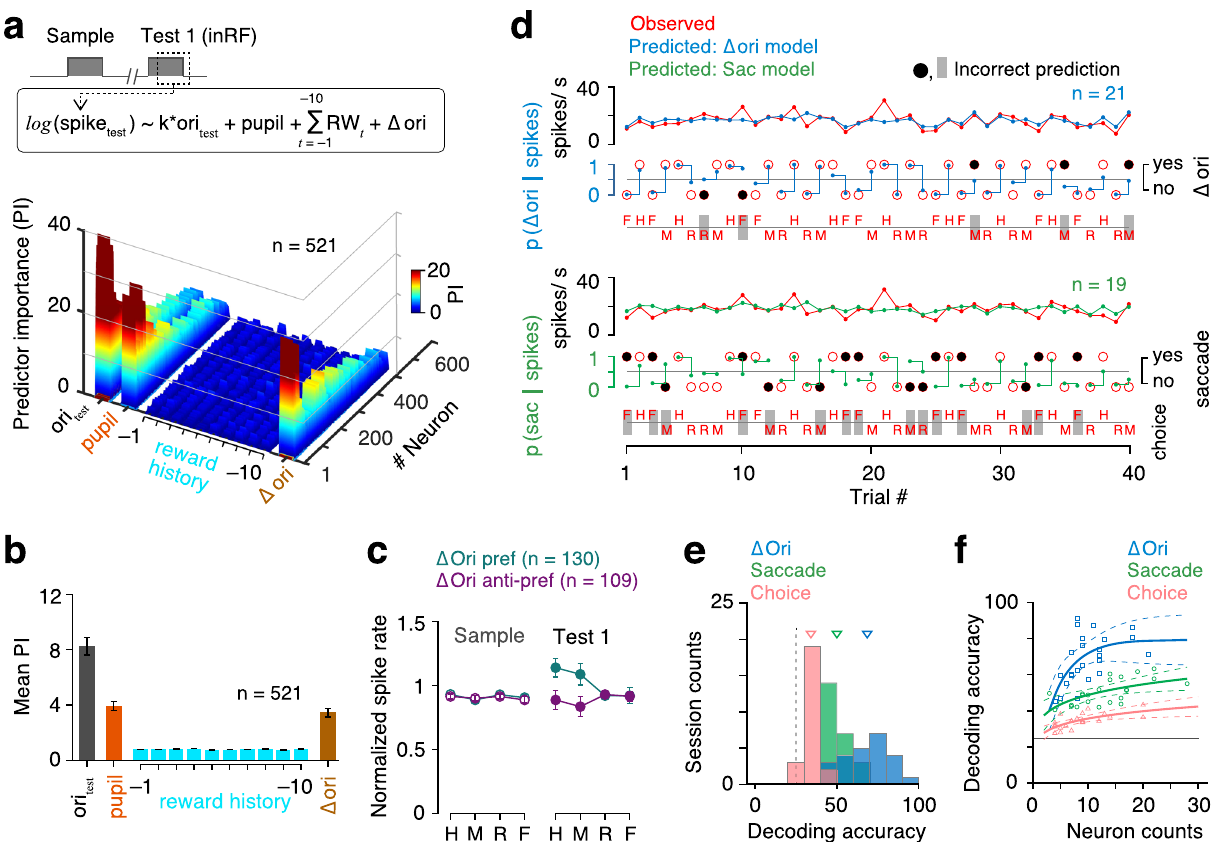
Fig. 7 V4 spikes encode change in stimulus orientation immediately before response selection. a Top, Δ ori model: GLM of spike counts during test